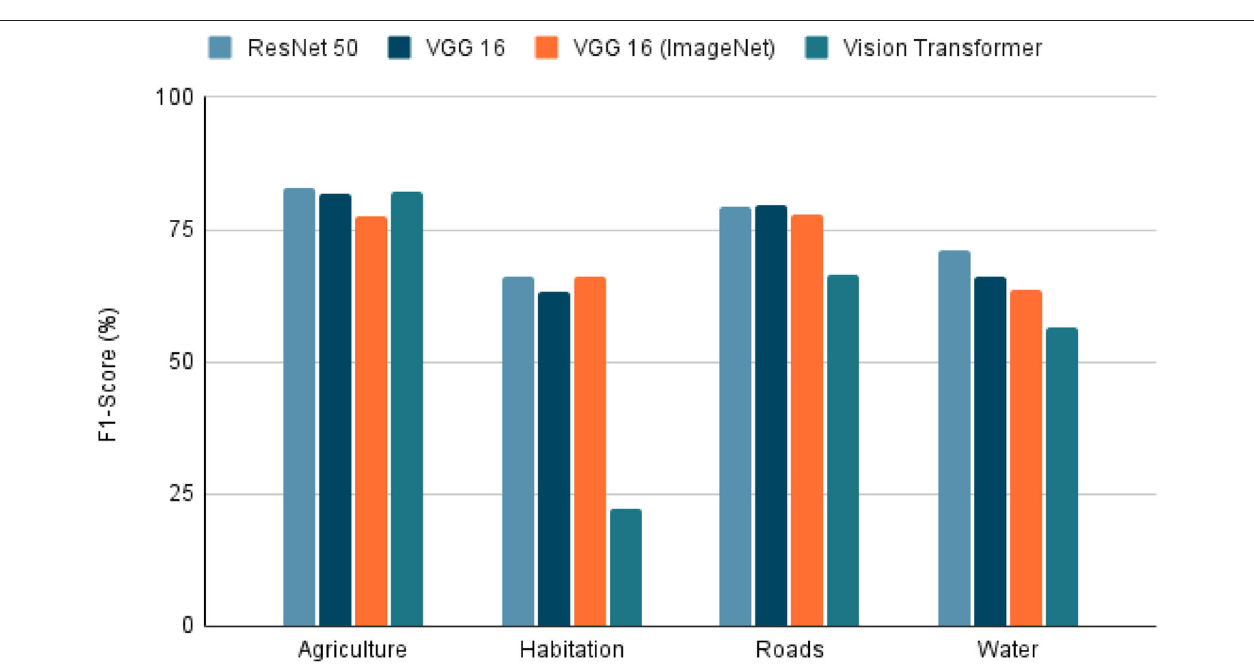
FIGURE 8 | F1-score on tested models. F1-score of the 4 models tested in the extraction of the 4 characteristics (agriculture, habitation, roads, whater). A highest value indicates a better performance in the classification task.